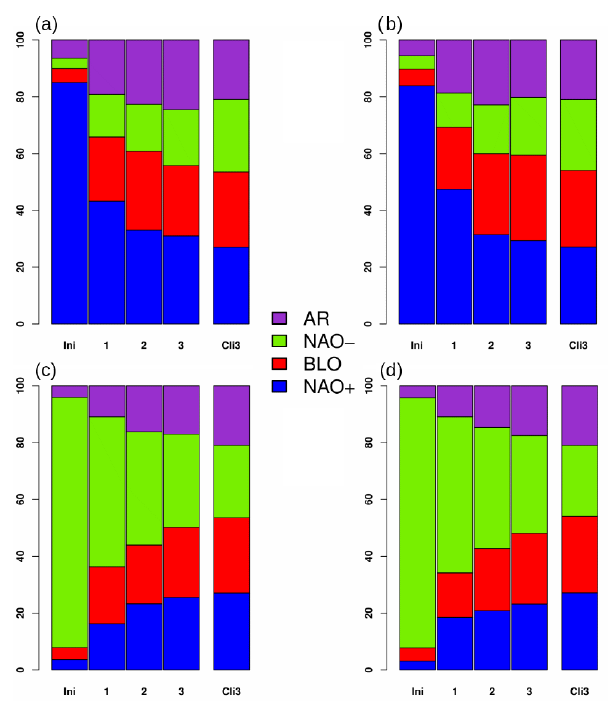
Figure 6. Weekly evolution of regime frequency among forecasts initialized in NAO+ (a) or NAO- (c) conditions for CNRM. (b, d) Same as (a) and (c) for ECMWF. The leftmost bar corresponds to the 4 initial days. The rightmost bar corresponds to the climatolog- ical frequency for week